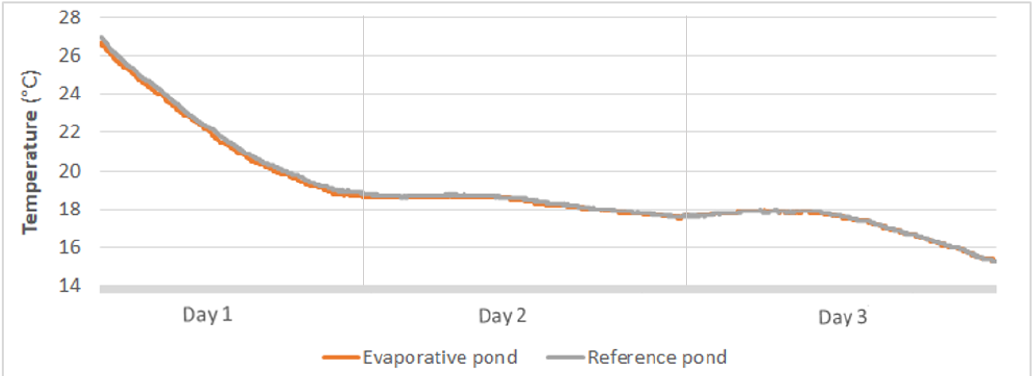
Figure 6. Water temperature fluctuation in the ponds (experiment 1).